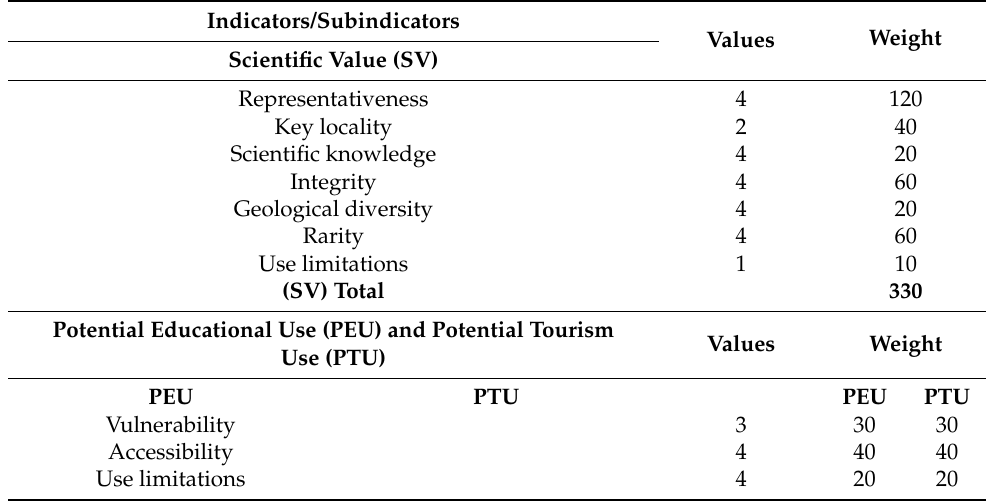
Table 5. Indicators used for the quantitative assessment of the MMMT by the Brilha